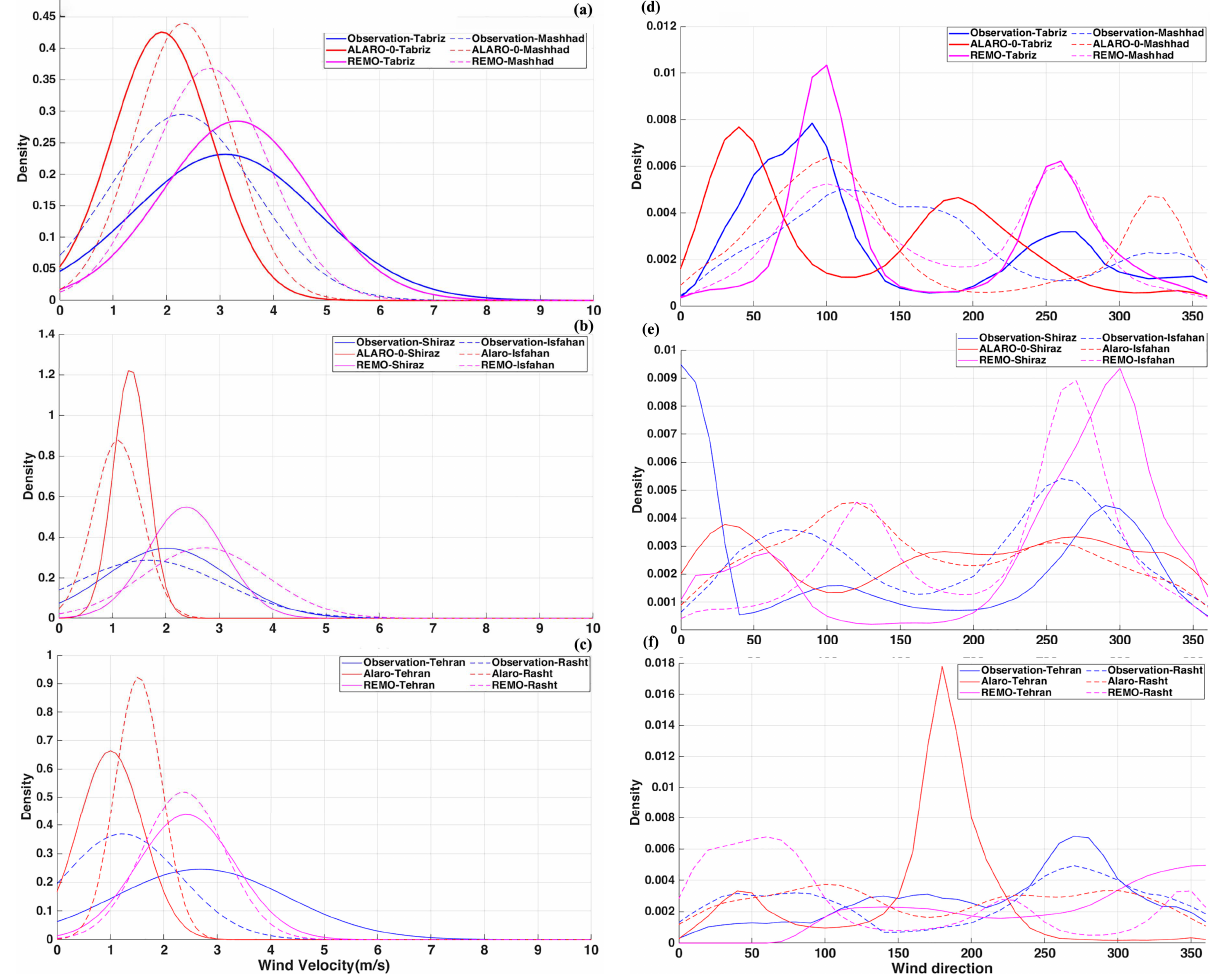
Figure 15. ( a–c ) PDF plot of average daily wind velocity and ( d–f ) six-hourly wind direction comparing ALARO-0 and Figure 15. ( a – c ) PDF plot of average daily wind velocity and ( d – f ) six-hourly wind direction comparing ALARO-0 and REMO RCMs with observations over six studied stations: ( a,d ) Tabriz and Mashhad, ( b,e ) Isfahan and Tehran, ( c,f ) Shiraz REMO RCMs with observations over six studied stations: ( a , d ) Tabriz and Mashhad, ( b , e ) Isfahan and Tehran, ( c , f ) Shiraz and Rasht during 1980–2017. and Rasht during